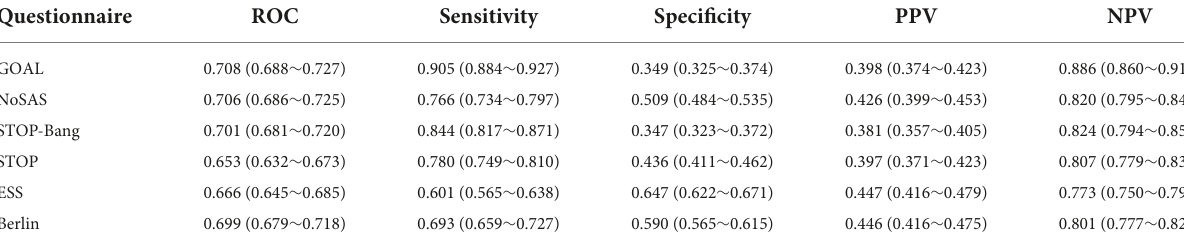
TABLE 4 Taking apnea hypopnea index (AHI) 30 as cut-off point for diagnosis of obstructive sleep apnea (OSA).